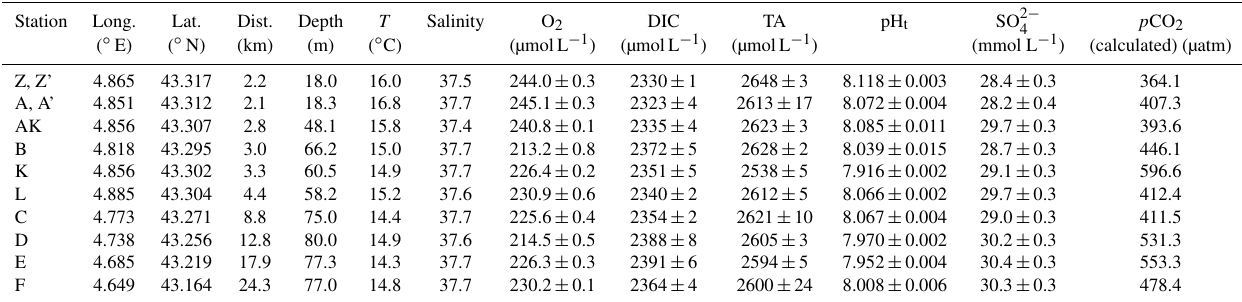
Table 1. Stations investigated during the DICASE cruise in June 2014 with the main properties of bottom waters; dist denotes the distance from the Rhône River mouth. Station Long.